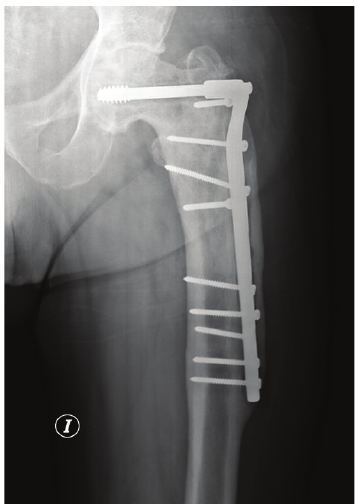
Figure 1: Preoperative AP radiograph of the left hip showing a healed intersubtrochanteric fracture with a dynamic condylar screw and osteosynthesis plate, coxa vara, and posttraumatic osteoarthri- tis.